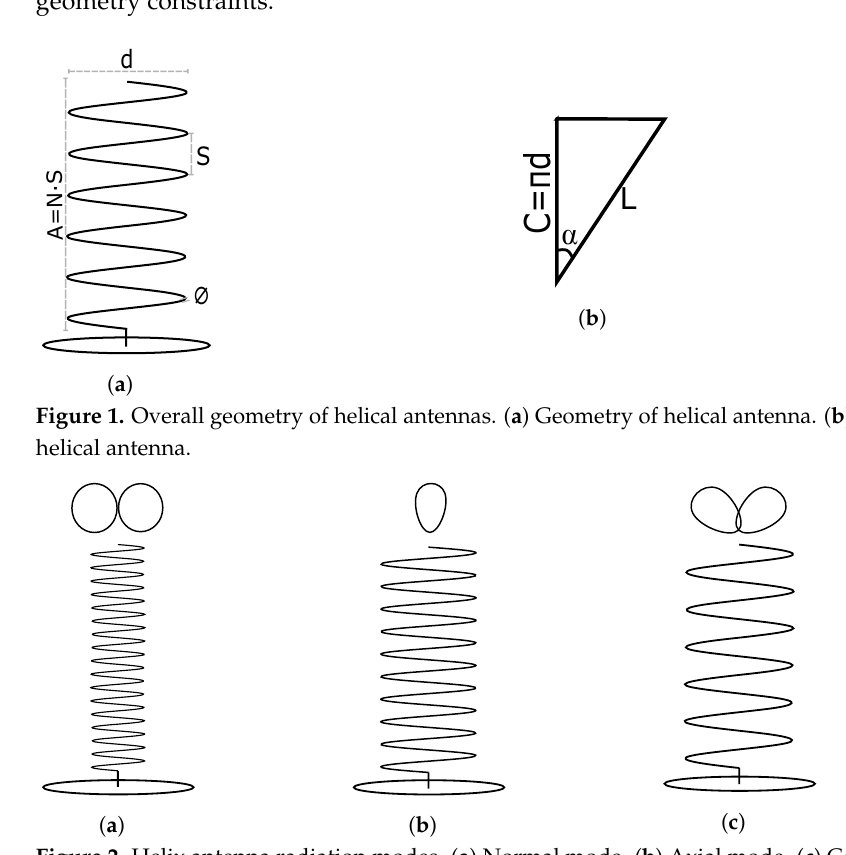
Figure 2. Helix antenna radiation modes. ( a ) Normal mode. ( b ) Axial mode. ( c ) Conical mode.